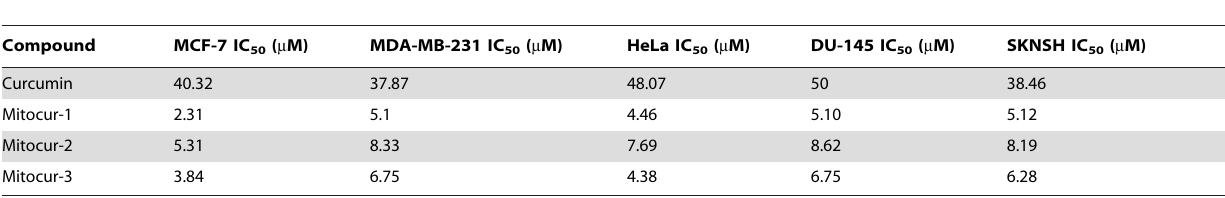
Table 2. Curcumin and Mitocur-1, 2 and 3 induce cell death in various cancer cells by SRB Assay.